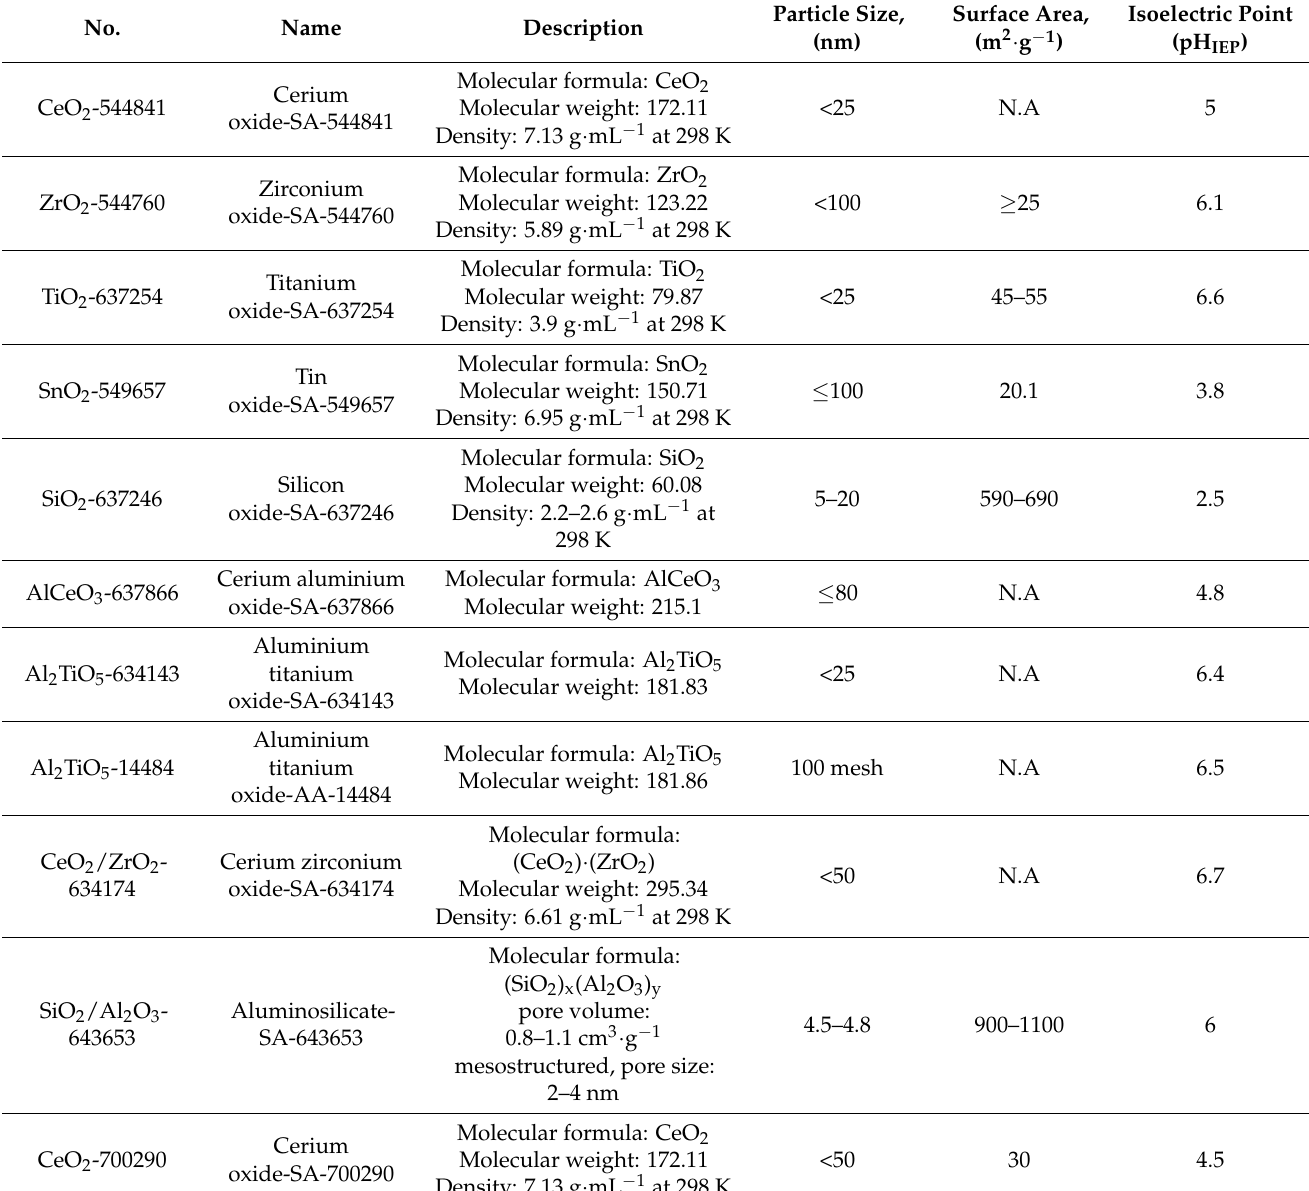
Table 1. Description of the analyzed commercial metal oxides NPs *